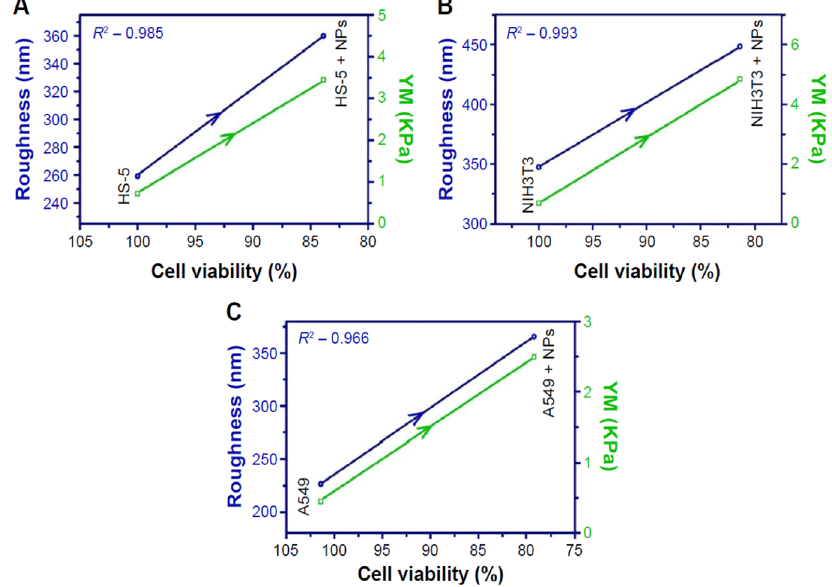
Figure 25. Correlation between cell viability and the roughness or stiffness of ( A ) HS-5, ( B ) NIH3T3 and ( C ) A549 cells before and after treatment with AgNPs. NP: nanoparticles; Y. M.: Young’s modulus. Reproduced from [226] with permission of Dove Medical Press Ltd.